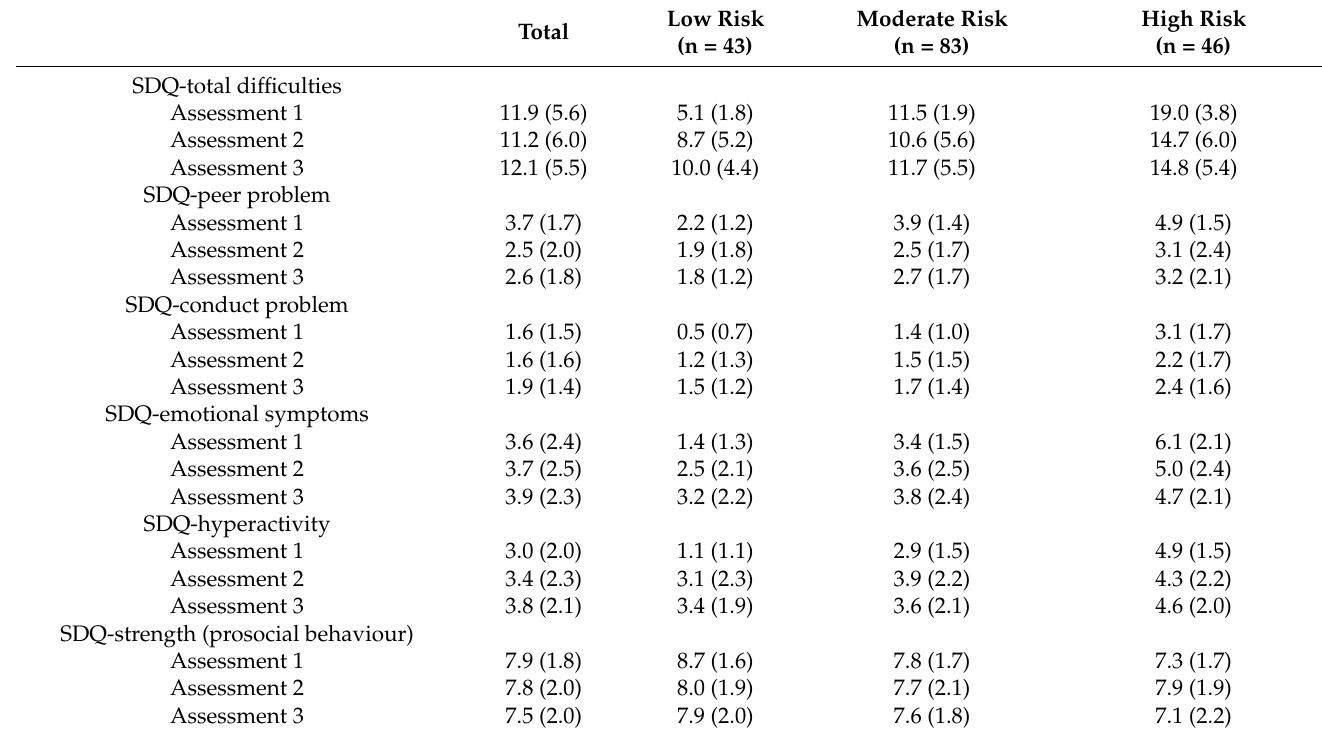
Table 3. Descriptive statistics for SDQ components, mean (SD).